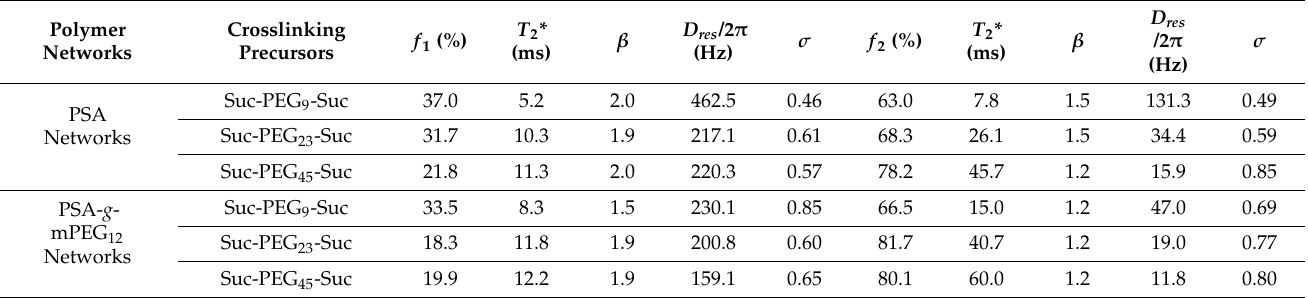
Table 2. Result of the simultaneous fitting to the double-quantum (DQ) data after the tail correction. The two network components are shown.